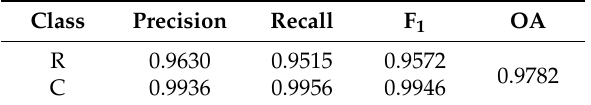
Table 1. The metrics of the model, including overall accuracy for the classification, precision and recall, as well as the F 1 score for road extraction from remote sensing imagery. Class Precision Recall